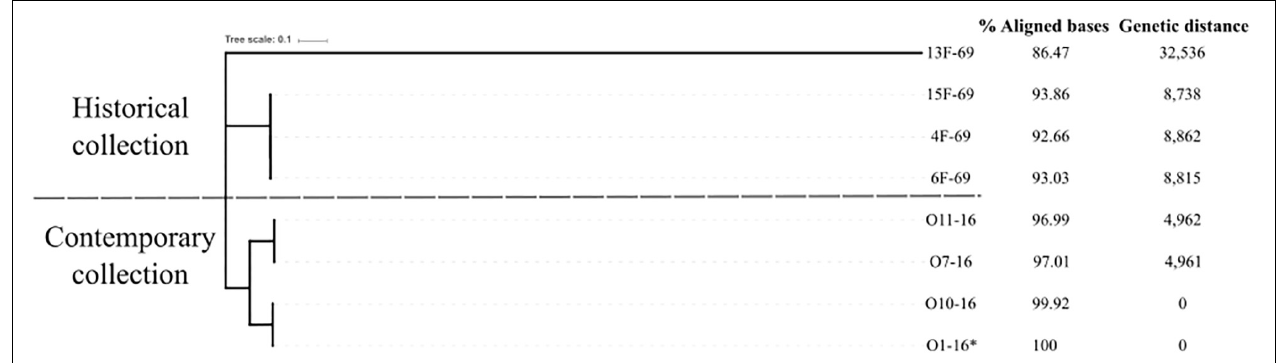
FIGURE 5 | Phylogenetic tree based on single-nucleotide polymorphism (SNP) analysis of the mapped sequences of the eight Serratia marcescens studied strains using the O1-16 strain as reference (*). Genetic distance was obtained by dividing the number of SNPs present in each genome by the aligned megabases with the